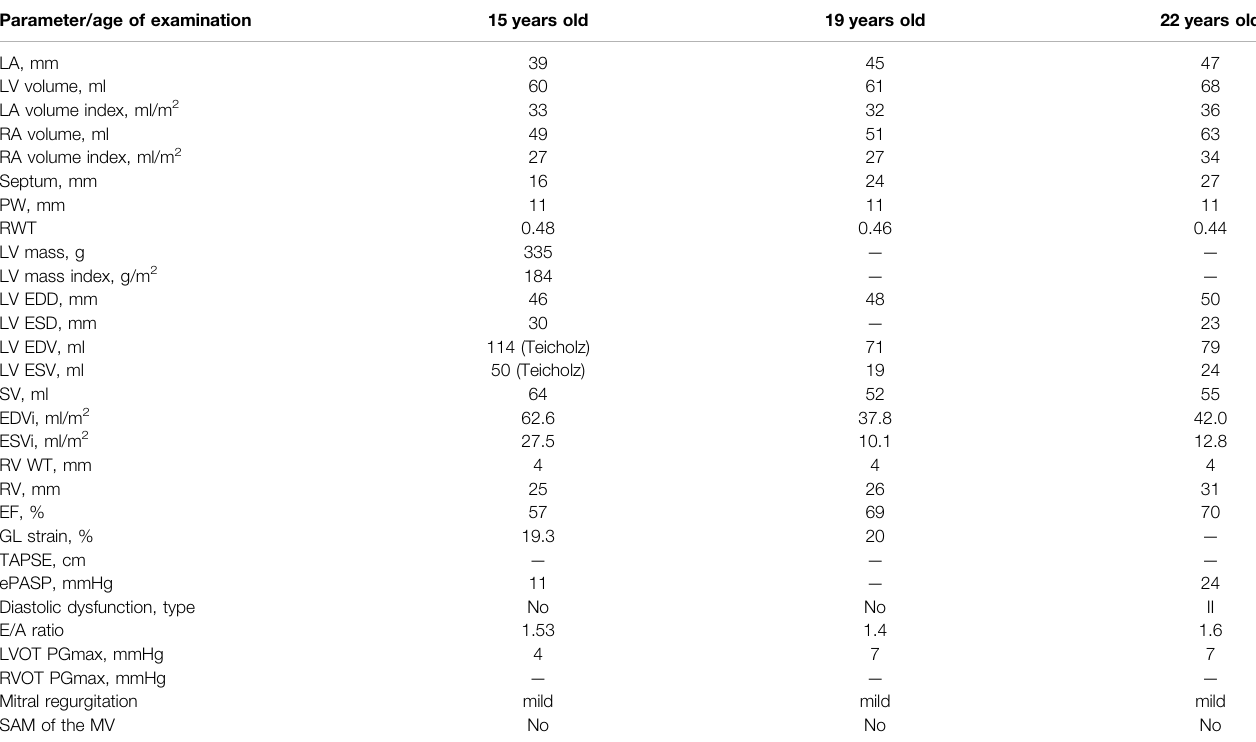
TABLE 3 | Dynamics of echocardiography data in Patient 2 Parameter/age of